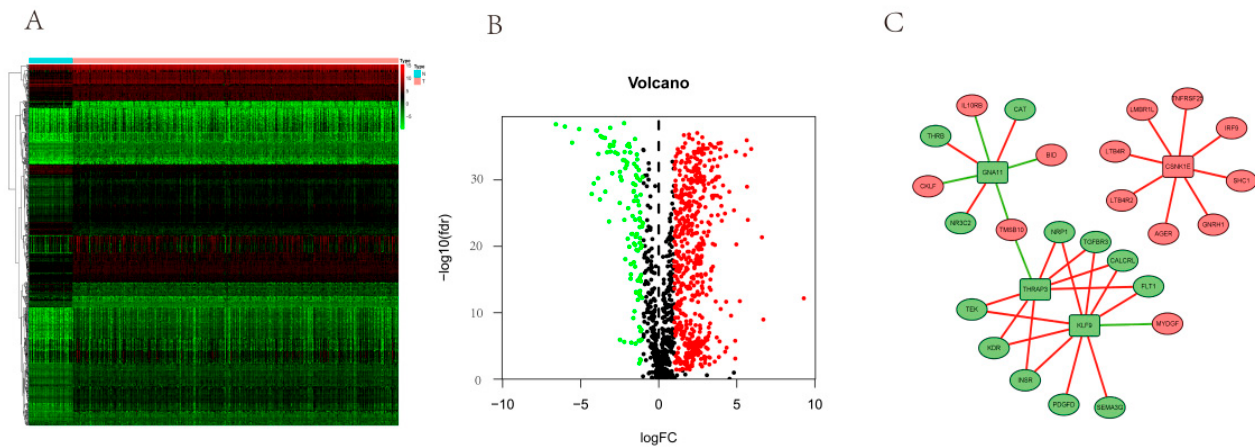
Figure 9. Regulatory networks of DERGs and immune genes. ( A ) Heatmap of immune genes in KIRC; ( B ) volcano plot of differentially expressed immune genes. p < 0.05, |log FC| > 2; ( C ) PPI network of DERGs and immune genes. The ellipse and rectangle represented immune genes and DERGs, respectively. The red and green colors represented the up-regulated and down-regulated genes, respectively. The red line represented positive regulation, and the green line represented negative regulation.